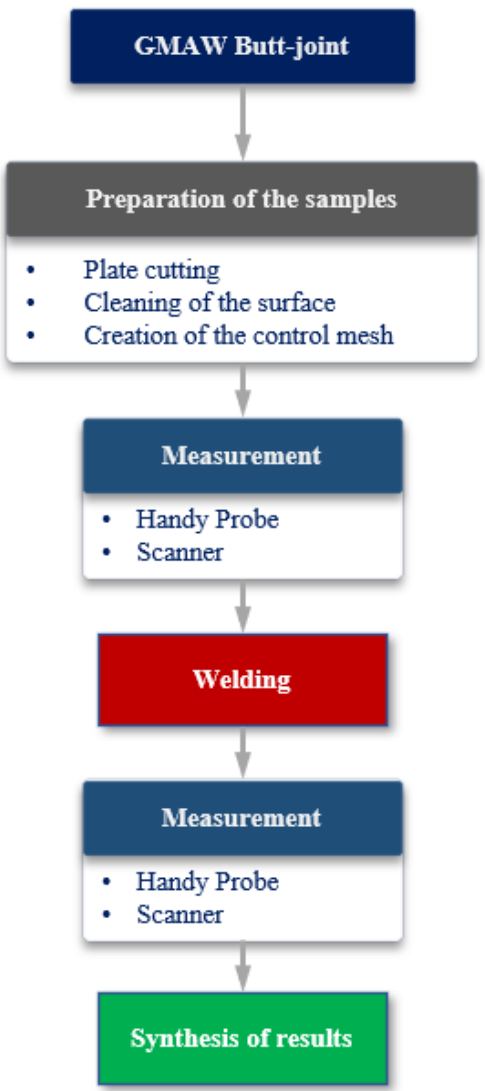
Figure 9. Methodology flowchart.